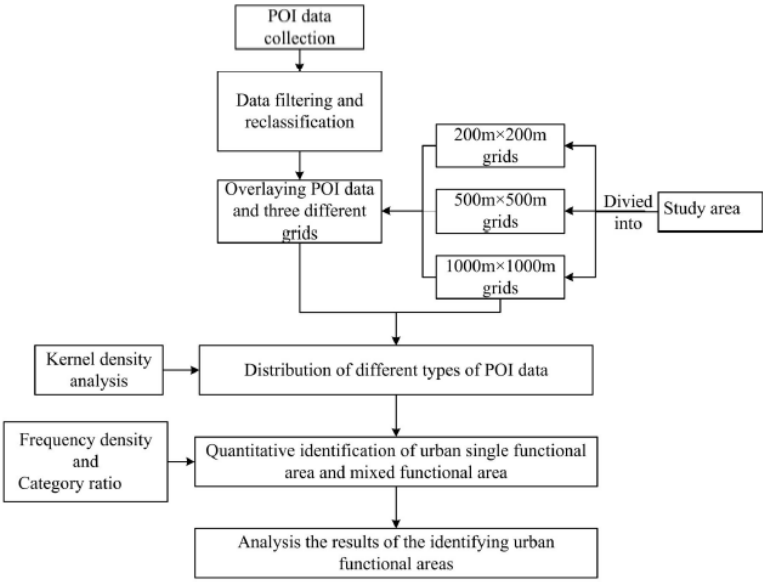
Figure 1. Research framework showing the steps employed in this study.